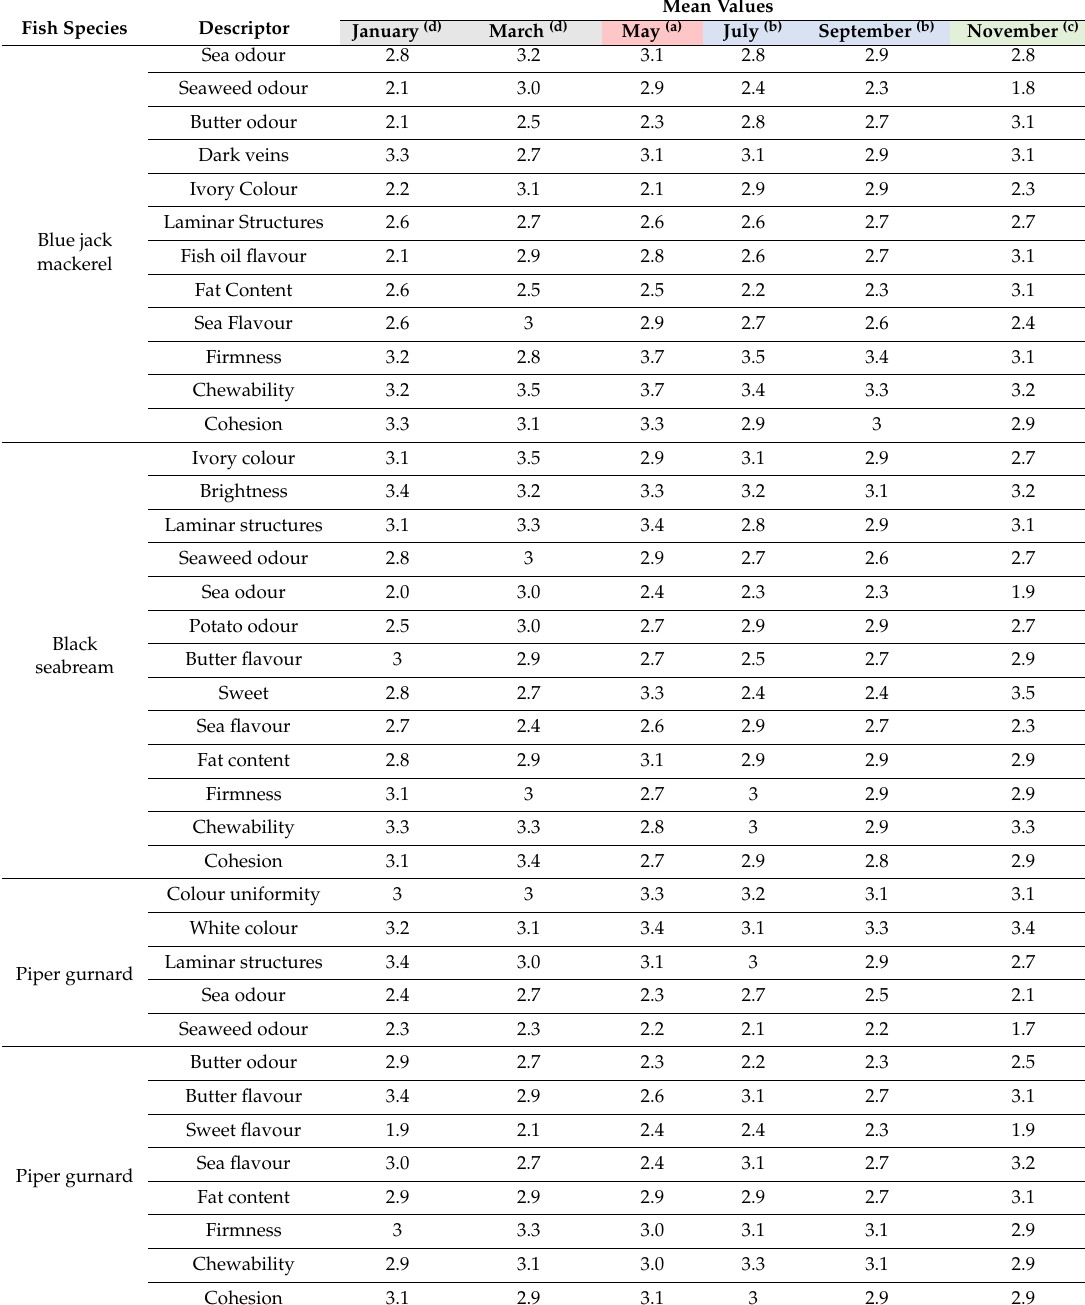
Table 2. Sensory descriptors’ mean range values for each fish species throughout the